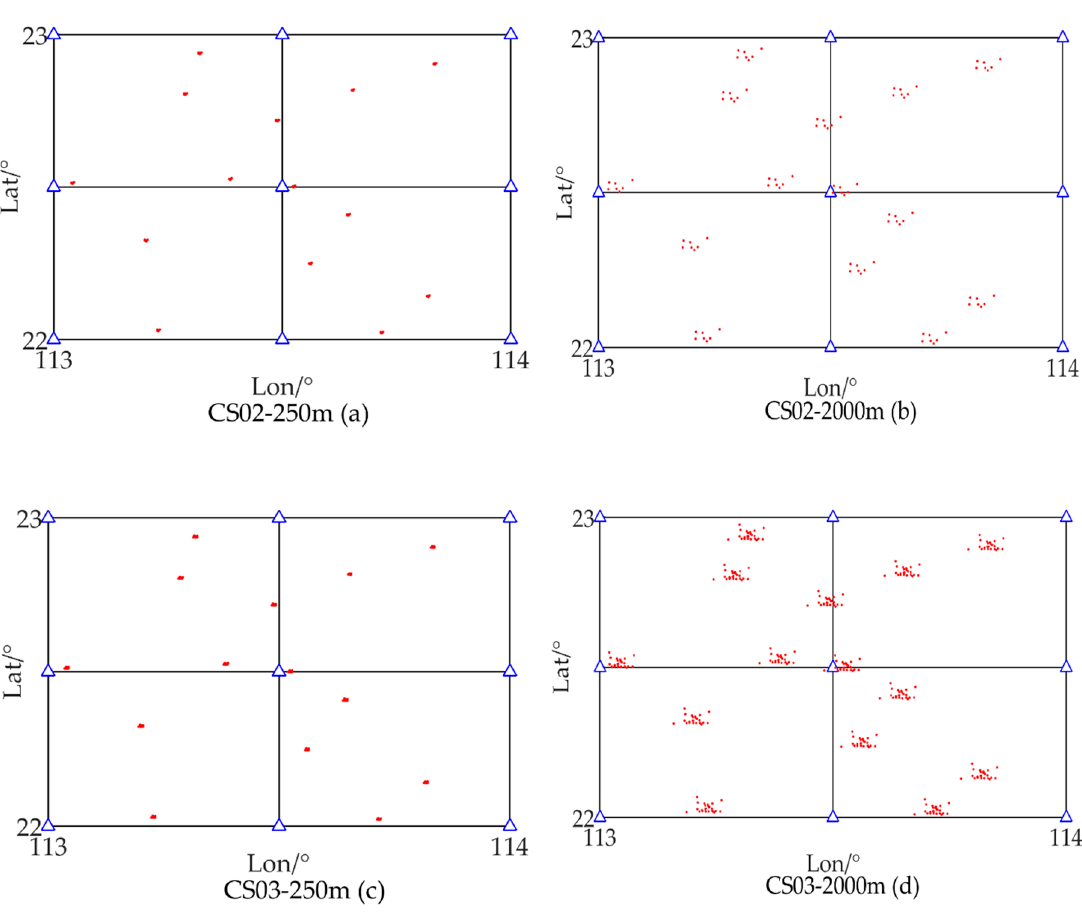
Figure 7. Horizontal cross-section at ( a ) 250 m layer in CS02; ( b ) 2000 m layer in CS02; ( c ) 250 m layer in CS03; ( d ) 2000 m layer in CS03. Triangles denote the to-be-estimated grid nodes. Red dots represent the puncture points of GNSS signals.